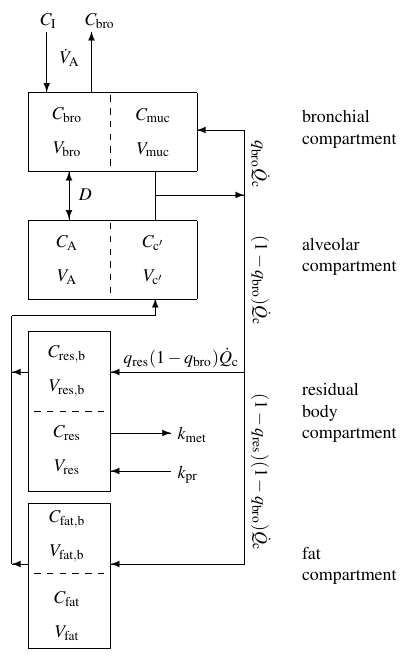
Figure 2. Sketch of the model structure. The body is divided into four distinct functional units: bronchial/mucosal compartment (gas exchange), alveolar/end-capillary compartment (gas ex- change), residual body (metabolism and production), and fat (storage). Dashed boundaries indicate a diffusion equilibrium. The conductance parameter D has units of volume divided by time and quantifies an effective diffusion barrier between the bronchial and the alveolar tract. Here, C denotes the corresponding concentrations, V the volumes, q res , q bro the relative corresponding blood flows, ˙ Q ˙ V c the cardiac output, A the alveolar ventilation, and k pr , k met the production and metabolic